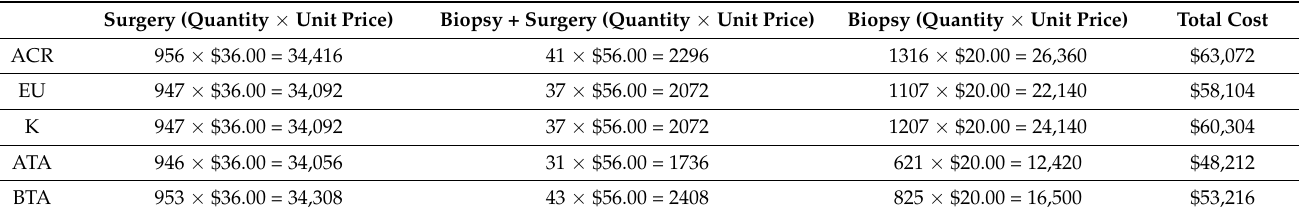
Table 21. Costs of the unnecessary operations to the